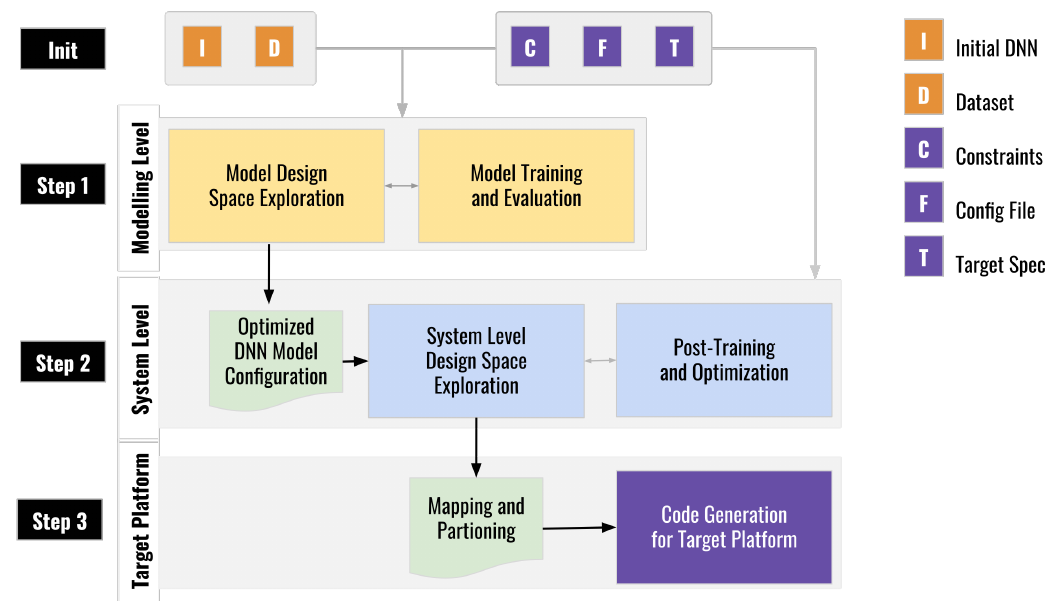
Figure 8. General architecture of the ALOHA software framework for Edge AI taking computational resource constraints at training time into account. Nodes in the upper part of the figure represent the key inputs of the tool flow specified by the users, for details see Reference